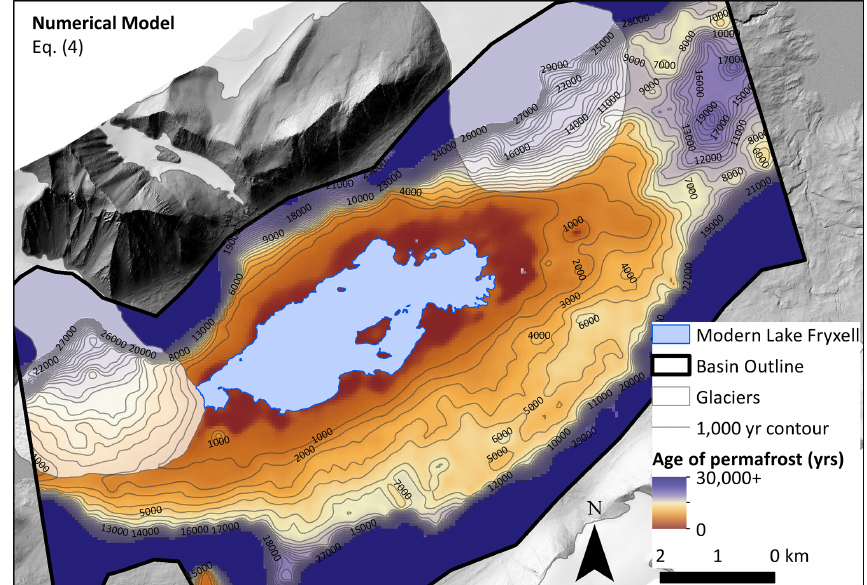
Figure 15. Numerical model results of permafrost age distribution in Fryxell basin calculated using Eq. (4). Age is calculated using depth to permafrost–brine boundary (defined as 100 (cid:127) m). Contours represent age of permafrost in years before present, implying higher lake levels (up to 81ma.s.l. sill level) during the Late Holocene, ∼ 4ka, which is older than the results from the analytical model shown in Fig. 14. Note that contours end at 30000 years BP. Because of such a large permafrost age gradient at high elevations, contours were illegible. The color ramp also stops at 30000 years BP since the model is not accurate for thick (hence older) permafrost. DEM (1m resolution) is from a 2014–15 lidar survey, accessed via OpenTopography (Fountain et al.,